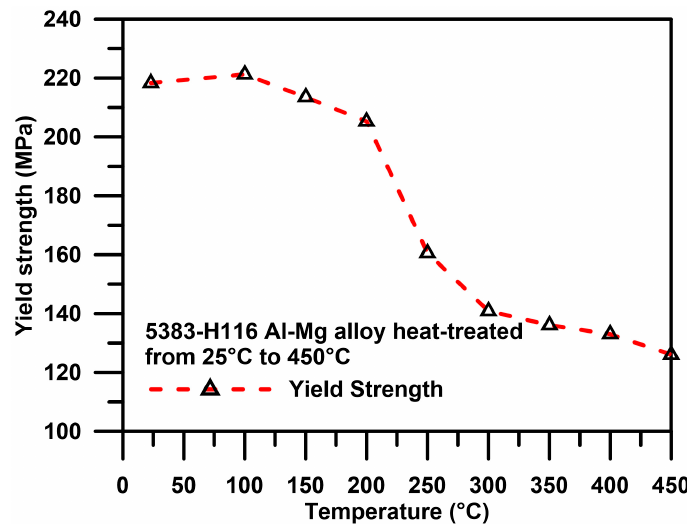
Figure 4. 5383-H116 tension test results after different annealing and sensitization treatment.